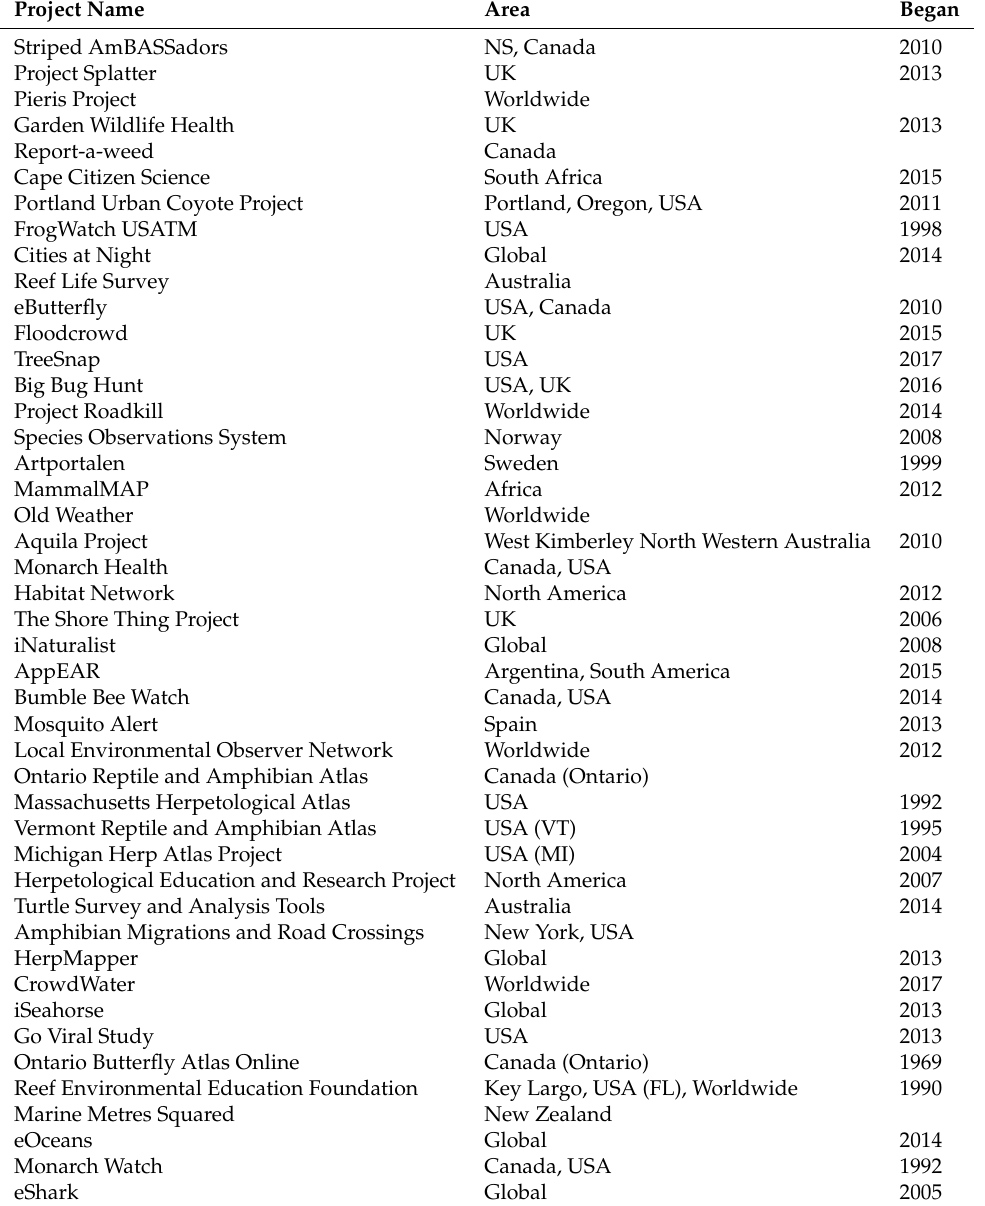
Table A2. Second half of accepted and analysed